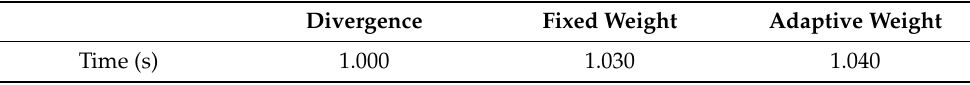
Table 9. Computational burden of the three algorithms in